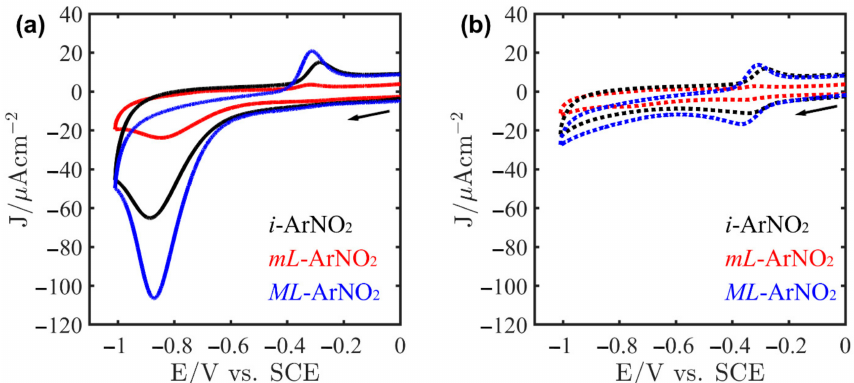
Figure 2. Cyclic voltametric response for the electrochemical reduction of surface-bound nitrophenyl groups; i -ArNO 2 (black), mL -ArNO 2 (red), and ML -ArNO 2 (blue) in N 2 -saturated Britton–Robinson buffer (pH: 11) at 50 mV s − 1 . ( a ) First scan (solid line); and ( b ) second scan (dotted